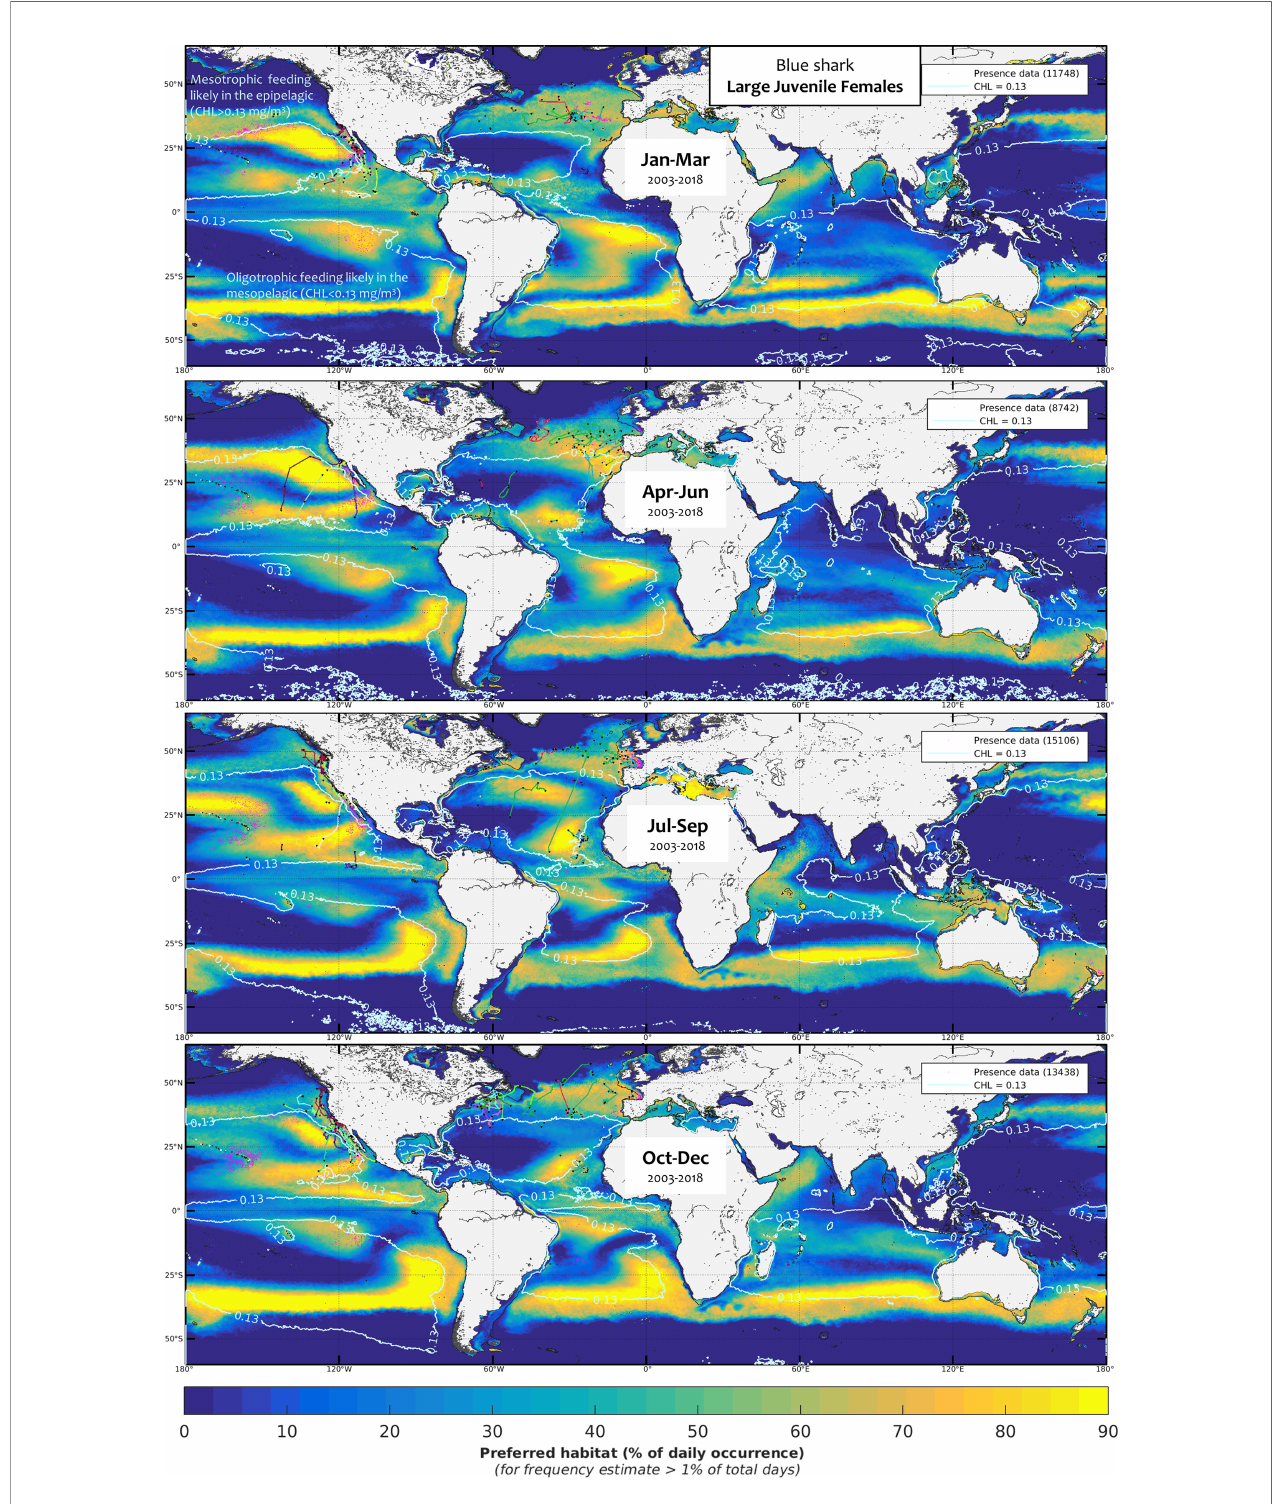
FIGURE 6 | Mean seasonal distribution of blue shark foraging habitat for the large juvenile females (LJF, 2003-2018, in frequency of suitable habitat occurrence, %). The chlorophyll-a isocontour of 0.13 mg.m -3 ( CHL min ) separates the mean area of oligotrophic foraging (below this value using mesopelagic micronekton as foraging proxy) and mesotrophic foraging (above this value using productivity fronts). Presence data (calibration and validation) are represented as pink dots for observer data and colored line transects for electronic tagging data (start and end of months are shown by a black star).